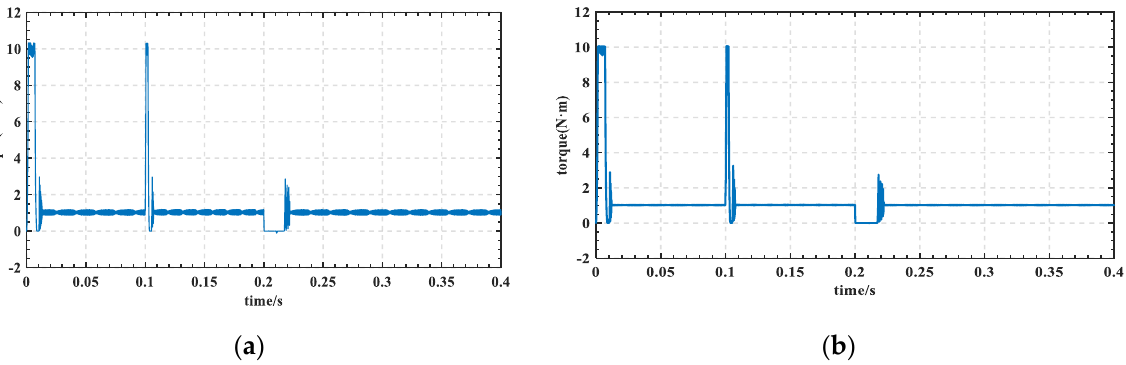
Figure 9. Comparison of torque ( a ) Torque of PID control system, ( b ) Torque of FNN control system.